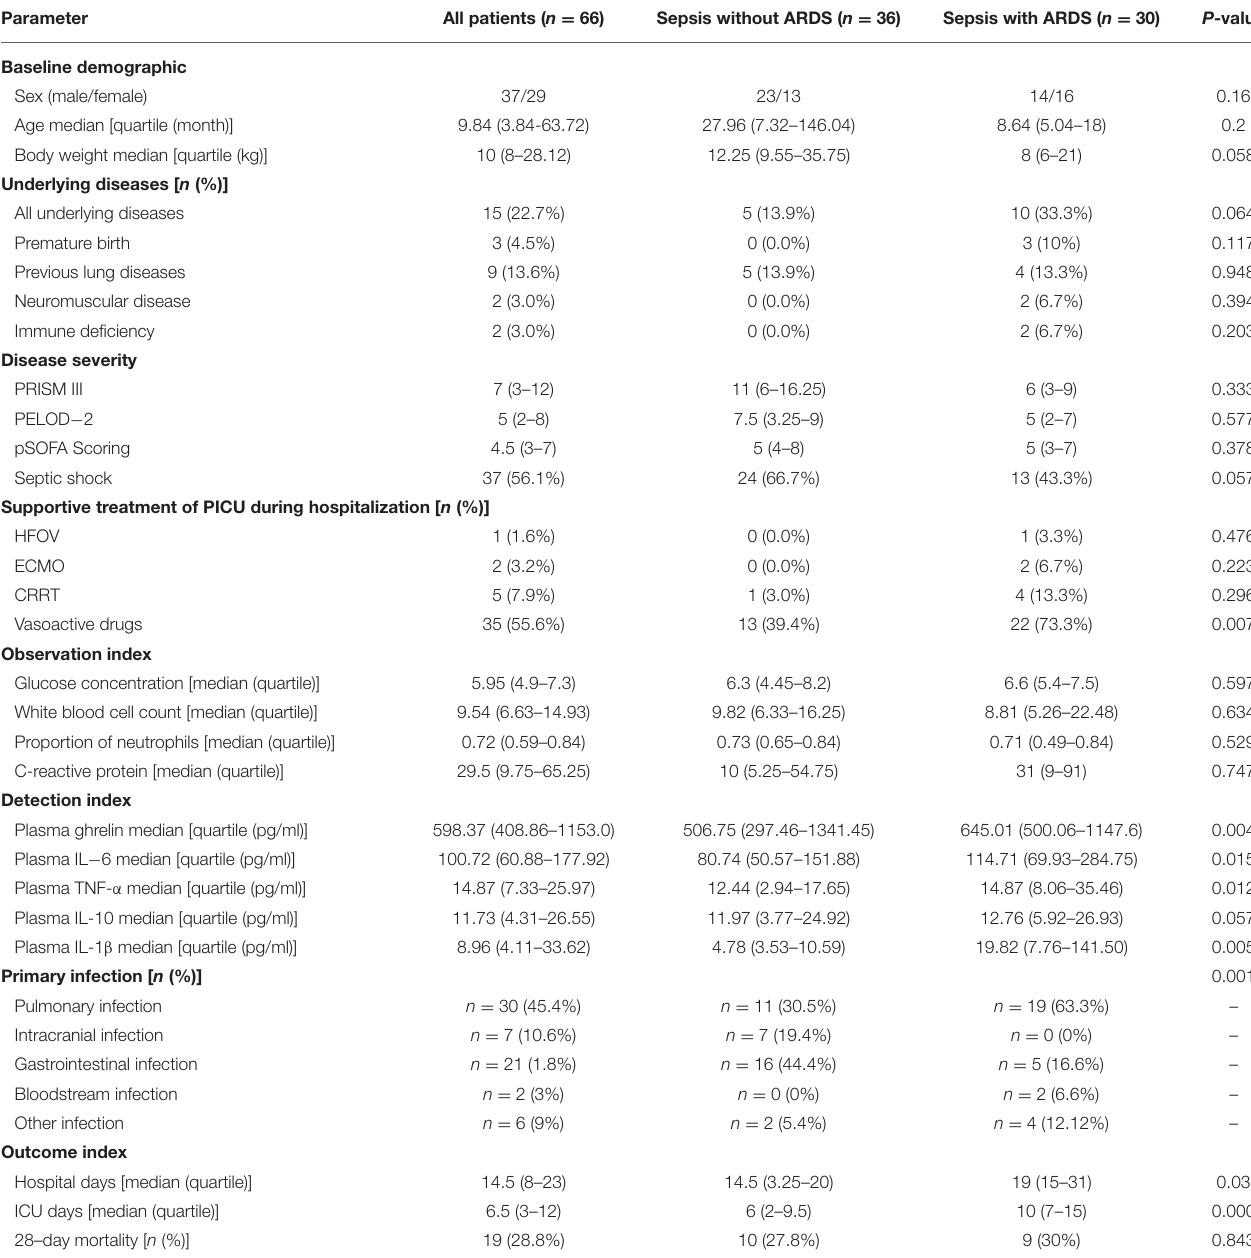
TABLE 1 | Baseline patient